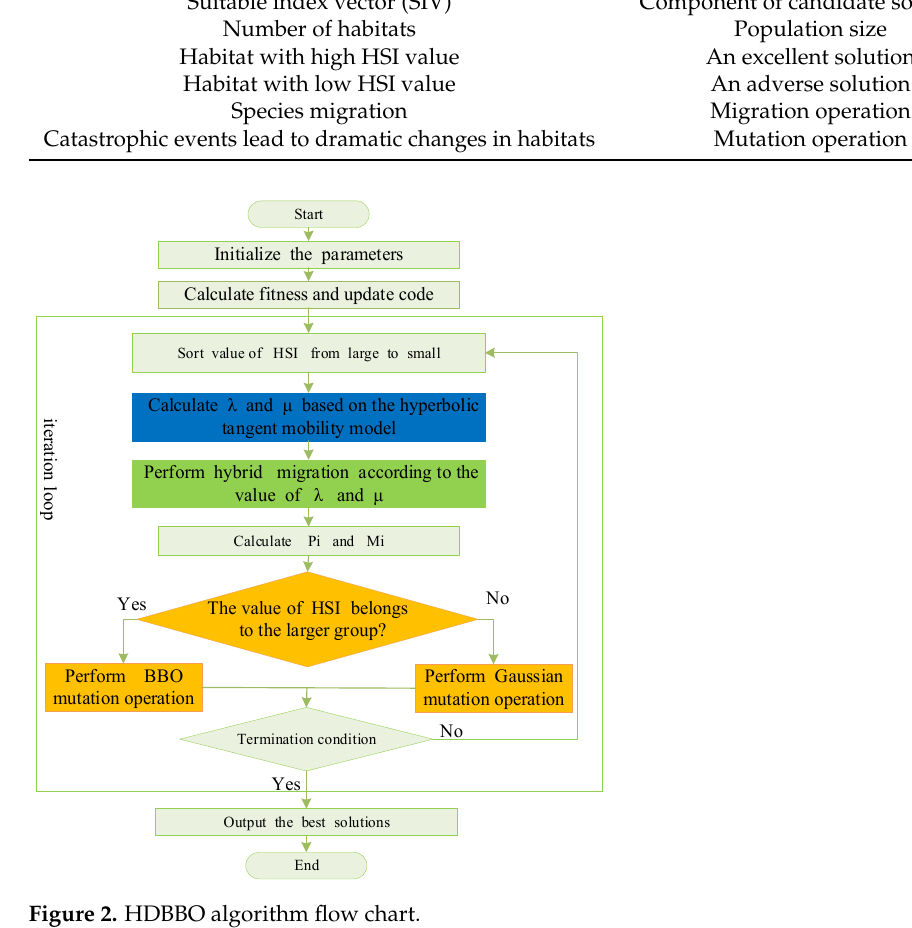
Figure 2. HDBBO algorithm flow chart.